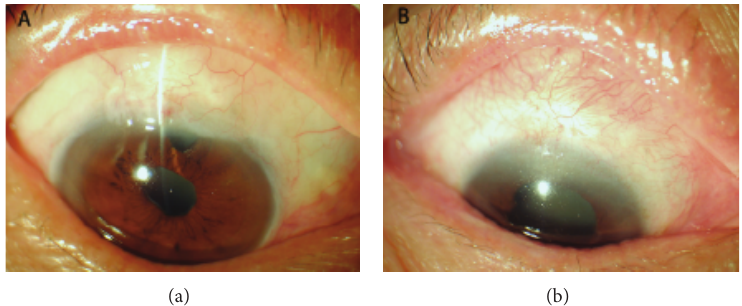
Figure 3: The bleb images in both groups at 5 years after surgery. (a) Elevated, diffused, well-formed filtering bleb in an eye that received Ologen implant trabeculectomy, with vascularization similar to that in the adjacent conjunctiva. (b) Flat, no function filtering bleb in an eye that received MMC trabeculectomy.